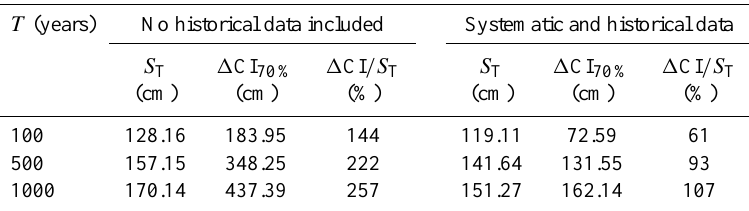
Table 2. The T -year quantiles (in cm) estimated on the basis of the systematic and historical periods and absolute and relative widths of their 70% confidence interval (the BMH frequency model).